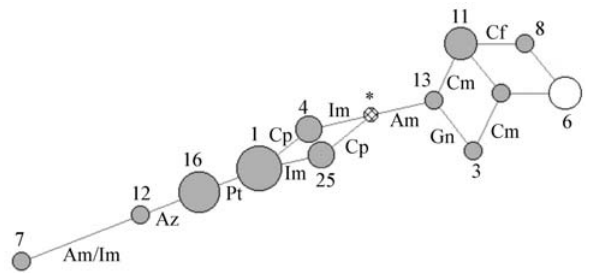
Figure 4 - Computational simulation of the evolution of antibiotic resis- tance by the P. aeruginosa clinical isolates investigated in this study. Each antibiogram pattern is considered to be one phenotype (haplotype) group that includes one or several bacterial isolates. The numbers represent group designations and the area of the circle corresponds to the number of isolates included in the group: 6 (isolates 6, 22 and 26), 11 (11, 28 and 29), 4 (4 e 33), 25 (25 and 27), 1 (1, 5, 10, 14 19 and 23) and 16 (16, 17, 18, 20 and 34). The remaining circles represent groups with only one isolate. The white circle was considered the base of the group network gray circles, while the dashed circle corresponds to a representative isolate of the R1T1 genotype that was not isolated among our bacterial samples (*). The dis- tances between each group are proportional to the number of steps in which one group evolved to the next, represented by expression of resis- tance to the following antibiotics: Amicacin (am), Aztreonam (az), Cefepime (cm), Cefotaxime (cf), Ciprofloxacin (cp), Gentamicin (gn), Imipinem (im) and Piperacilin/Tazobactam